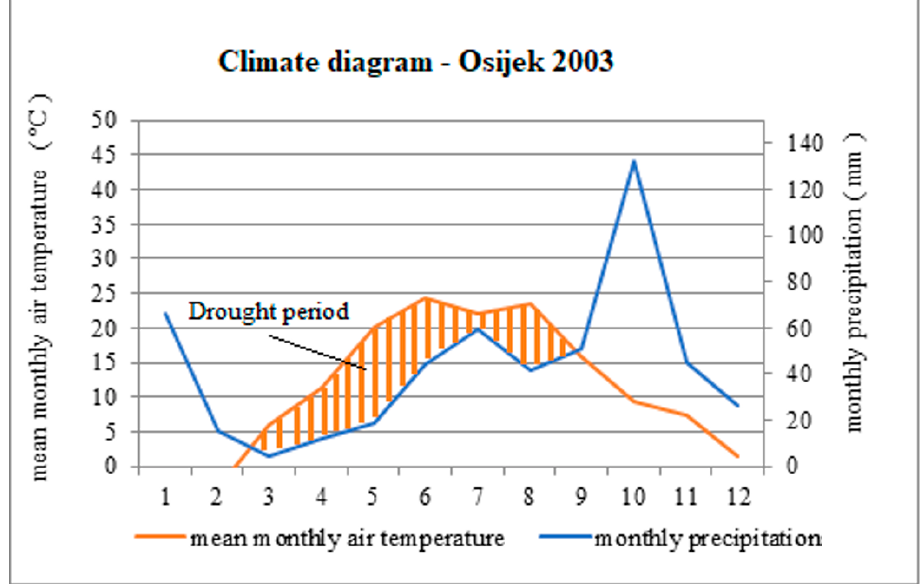
Figure 7. Climate diagram for Osijek, Croatia for the year 2003.